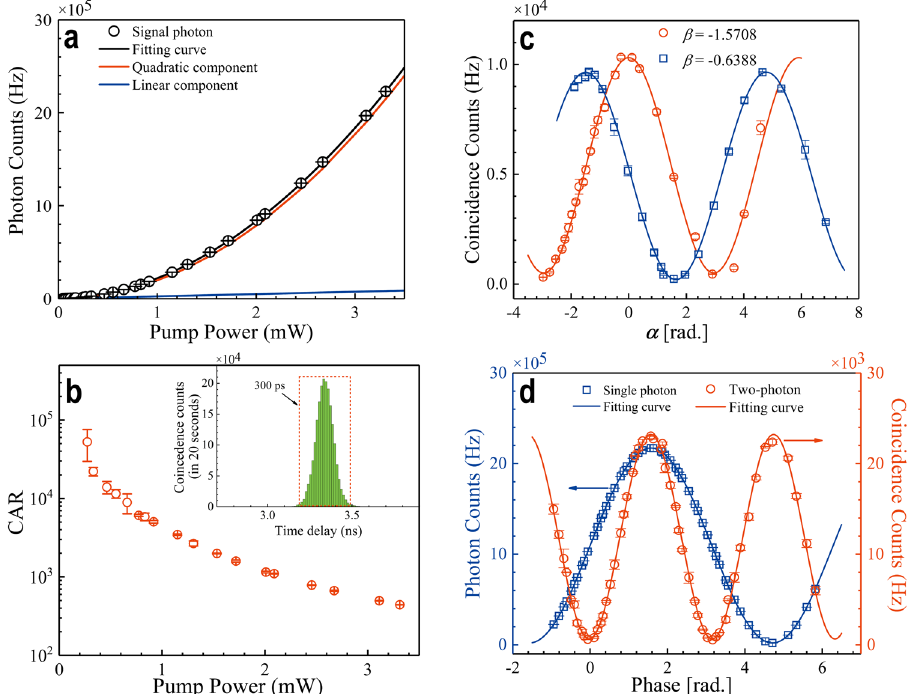
Fig. 3 Results of correlated and energy – time entangled photon-pairs. a Photon-counting rate (black circle) in signal channel versus pump power. The black solid line is the quadratic polynomial fi tting curve of the photon-counting rate with the quadratic and linear parts shown as the red and blue curves, respectively. The error bars are estimated by Poissonian photon-counting statistics. b Measured CAR versus pump power. The error bars are estimated from the statistical errors of the coincidence and accidental coincidence counts, in which the former is obtained by assuming Poissonian statistics and the latter is estimated by the standard deviation values of accidental coincidence in three 300- ps time windows away from the coincidence peak. The inset is the coincidence histogram between signal and idler photons when the pump power is set at ~2 mW, and a coincidence window of 300 ps is marked. c Results of Franson interference for β = − 1.57 (red circle) and β = − 0.64 (blue rectangle). d Results of two-photon interference (red circle) and single-photon interference (blue rectangle). The error bars of coincidence count in ( c , d ) are estimated by repeating the measurement three times, while the error bars of photon counts in ( d ) are obtained by Poissonian photon-counting